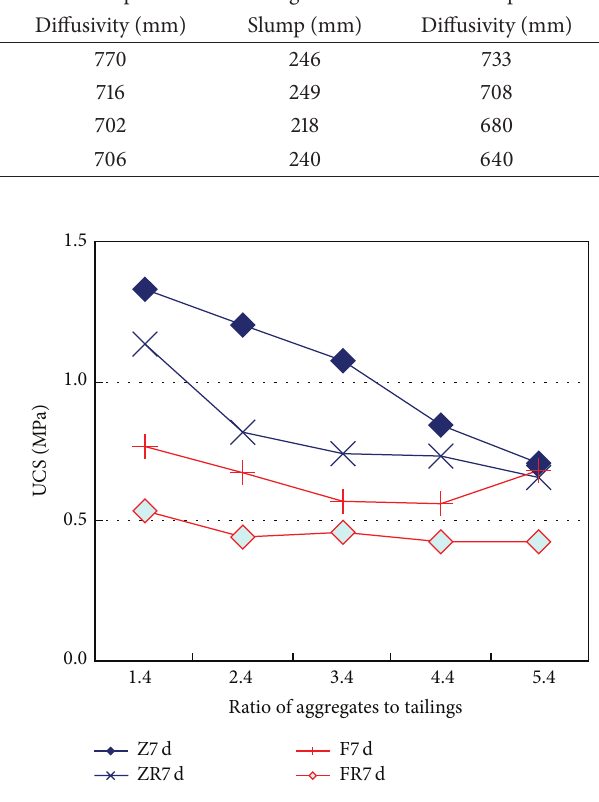
Figure 4: 7-day backfill UCS using 12% cement